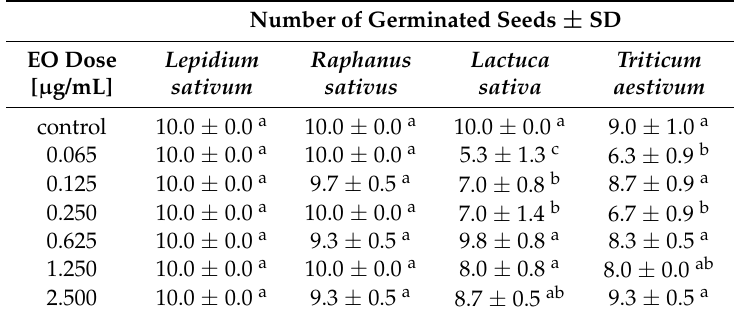
Table 2. Effect of different doses of the essential oil from aerial parts of Heracleum mantegazzianum on the seed germination of four model plant species.